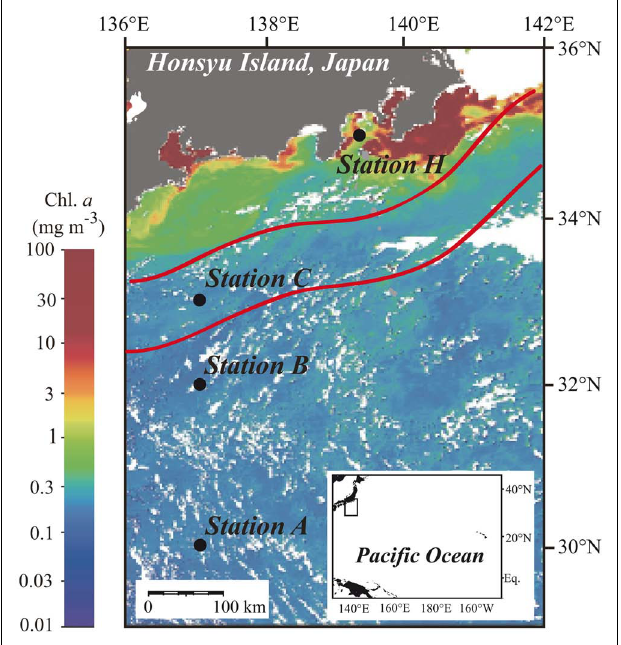
FIGURE 1 | Locations of sampling stations in the western North Pacific Ocean superimposed on the moderate resolution imaging spectroradiometer (MODIS) chlorophyll image from 19 July 2010. White areas have no data because of cloud cover.The MODIS chlorophyll image is courtesy of the Japan Aerospace Exploration Agency (JAXA) andTokai University.The red lines indicate the northern and southern boundaries of the Kuroshio Current on 14 July 2010 (Marine Information Service Office, Oceanographic Data and Information Division, Hydrographic and Oceanographic Department, Japan Coast Guard,